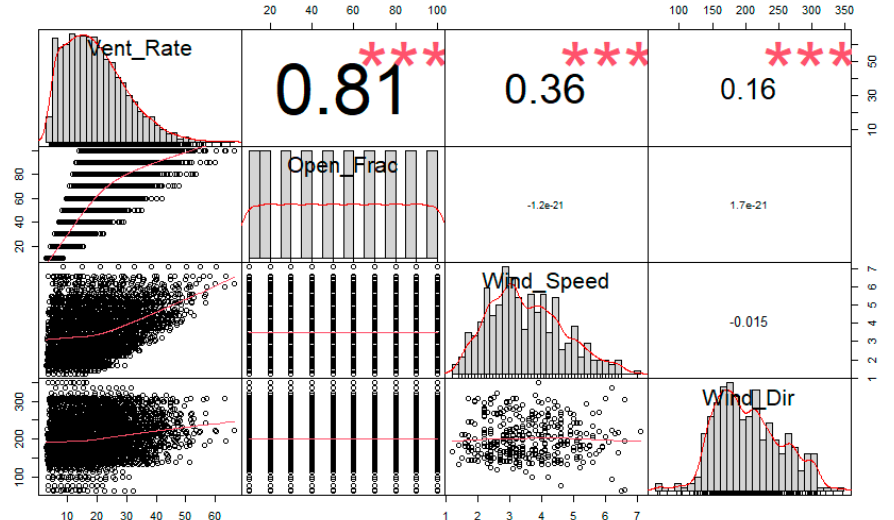
Figure 9. Scatter plot and correlation of the indoors ventilation rate against window opening fraction, wind speed and wind direction. Note: *** Vent_Rate: Ventilation Rate, Open_Frac: Opening Fraction, Wind_Dir: Wind Direction.